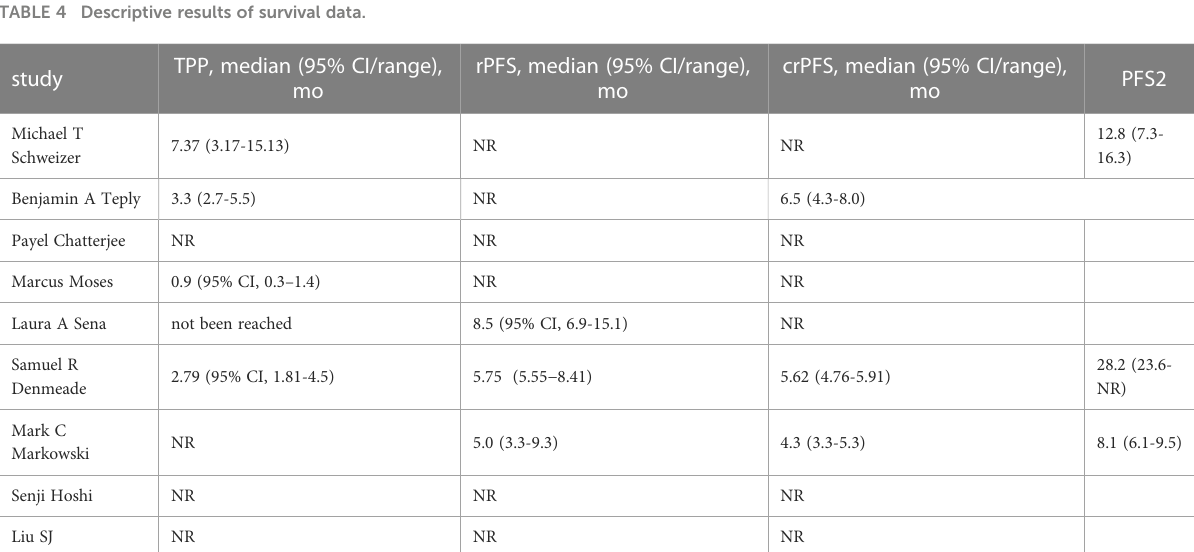
TABLE 4 Descriptive results of survival